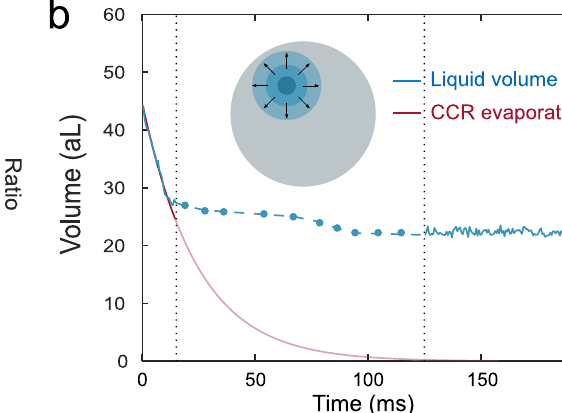
liquid fi lmonthedisksurface. b Thedetectedvolumeofliquidasafunctionoftime is fi nallydeducedbyFEMsimulations(seemaintext).Theevaporationconsists fi rst of the CCR evaporation stage governed by the Kelvin effect, followed by the spreading of a puddle precursor fi lm illustrated in blue (at t =54 ms, puddle dia- meter=3.5 μ m, height=2.7nm; at t =104ms, puddle diameter=6.6 μ m, height= 0.7nm), and ends with the stabilization of an extended fi lm on the